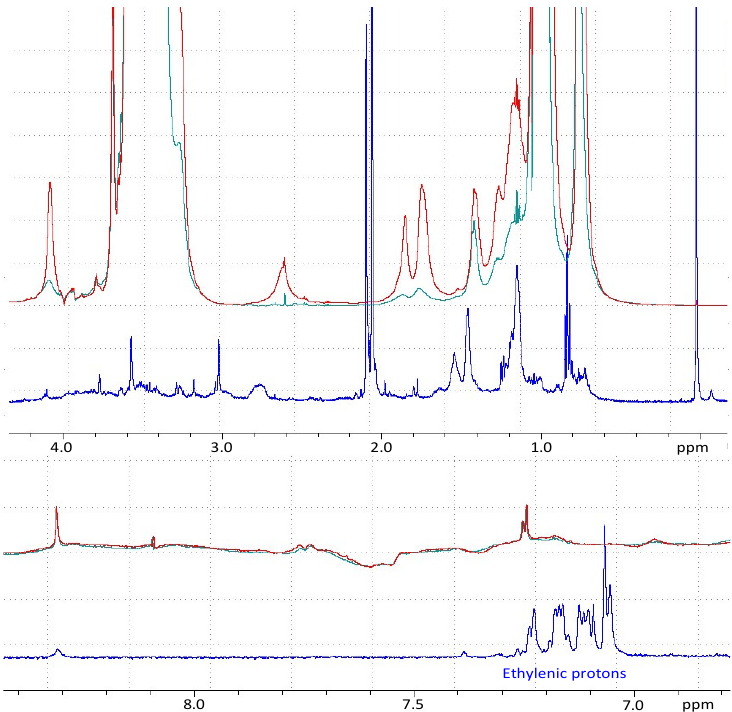
Figure 2. Nuclear magnetic resonance (NMR) spectra of rapamycin (blue line), drug-free micelles (red line) and rapamycin-loaded micelles (green line) in deuterated water.